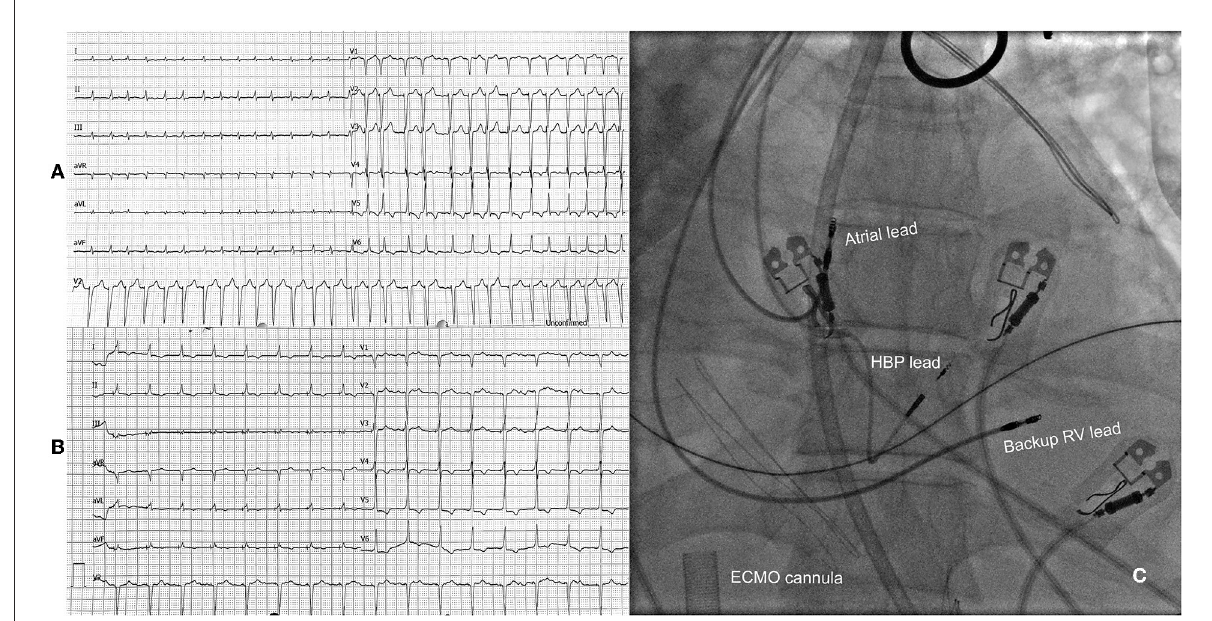
FIGURE2 (A) Electrocardiogram at admission with visible atrial fibrillation with a ventricular rate of 175 bpm. (B) Electrocardiogram after atrioventricular node ablation and His bundle pacing. (C) Position of pacing leads during fluoroscopy with visible ECMO cannula in the background. HBP, His bundle pacing; RV, right ventricle; ECMO, extracorporeal membrane